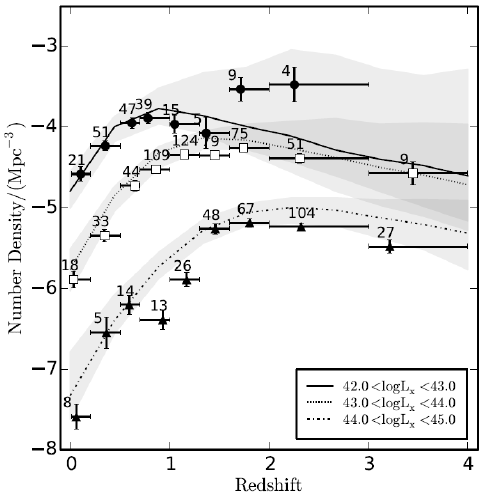
Figure 1. The number density of quasars from X-ray data [2]. Solid, dashed, and dash-dotted lines show AGN number densities for different luminosity ranges.